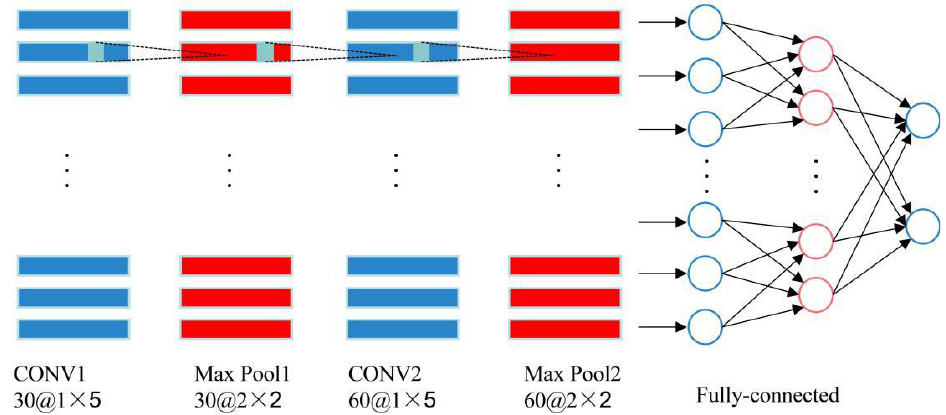
Figure 4. The structure of the proposed CNN.